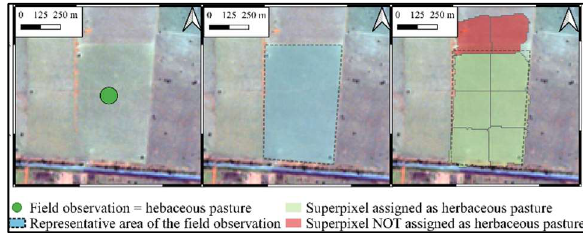
Figure 2: Example of class assignment considering one field observation and the respective representative area in blue. Visual